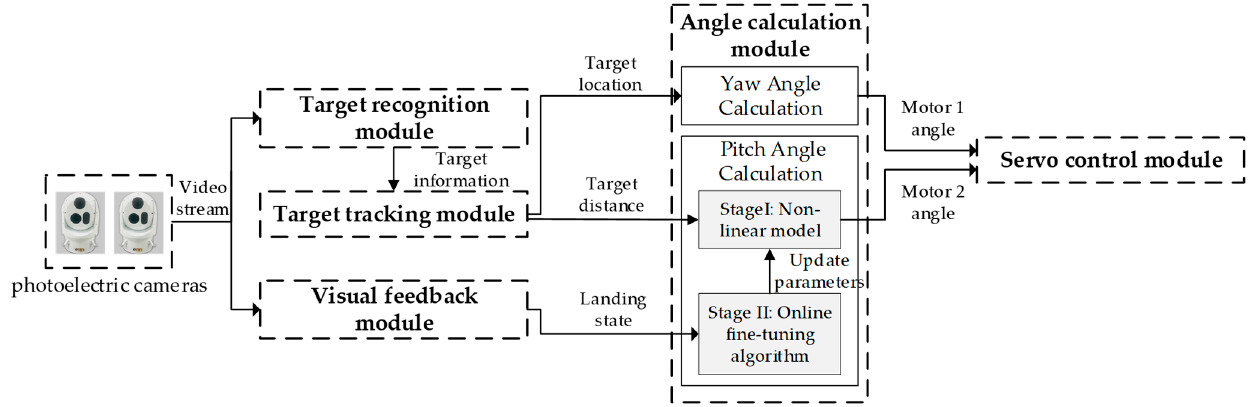
Figure 5. Process of online parameter adjustment method based on the back-propagation algorithm.